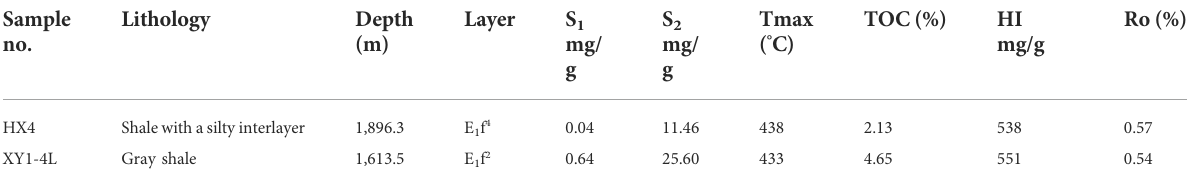
TABLE 3 Geochemical characterization of source rock samples used for pyrolysis. Sample no.